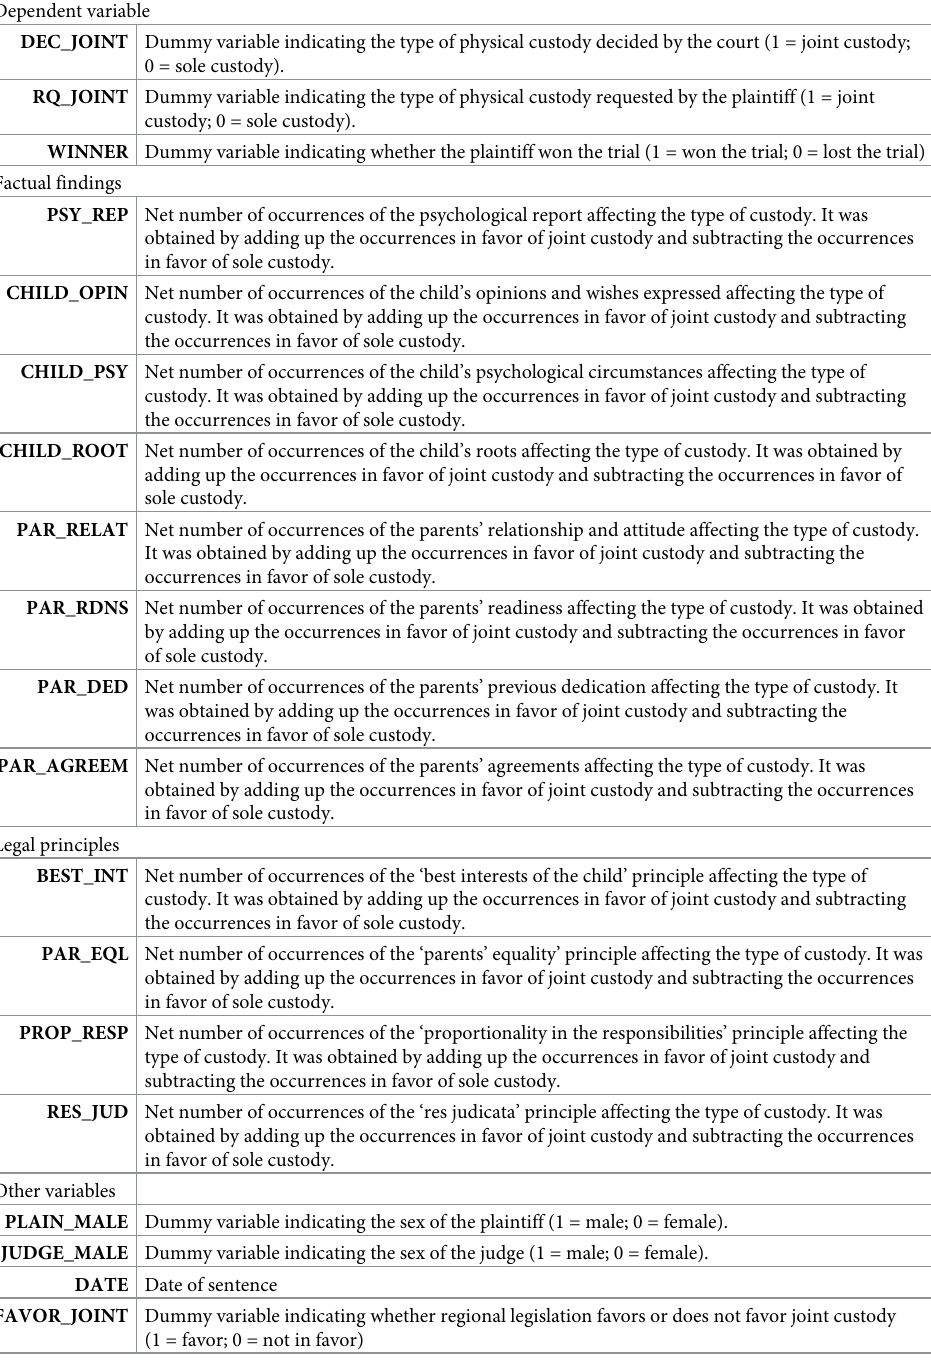
Table 1. The variables used in the study and their